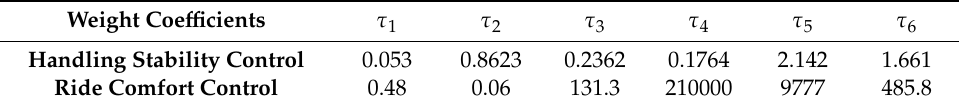
Table 4. Weight coe ffi cients of the